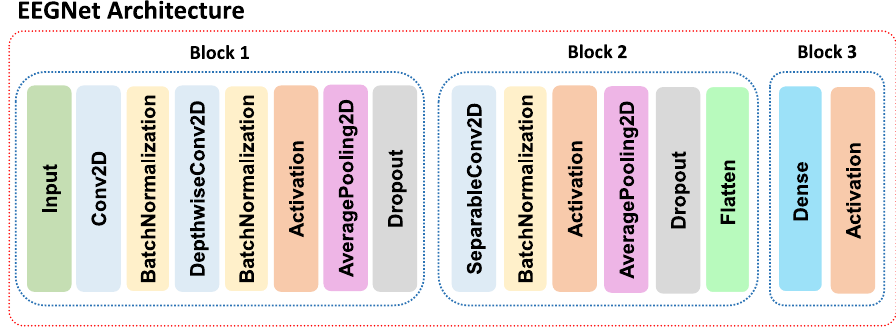
Figure 3. EEGNet baseline